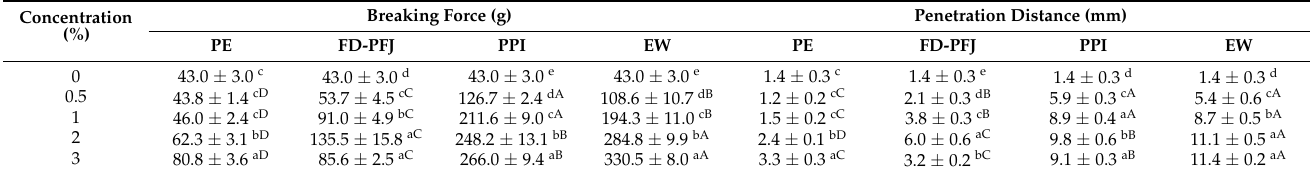
Table 3. Breaking force and penetration distance of the Pacific whiting surimi gels with four different inhibitors (PE, FD-PFJ, PPI, and EW) at 0, 0.5, 1, 2, and 3% levels held at 60 ◦ C for 30 min prior to heating to 90 ◦